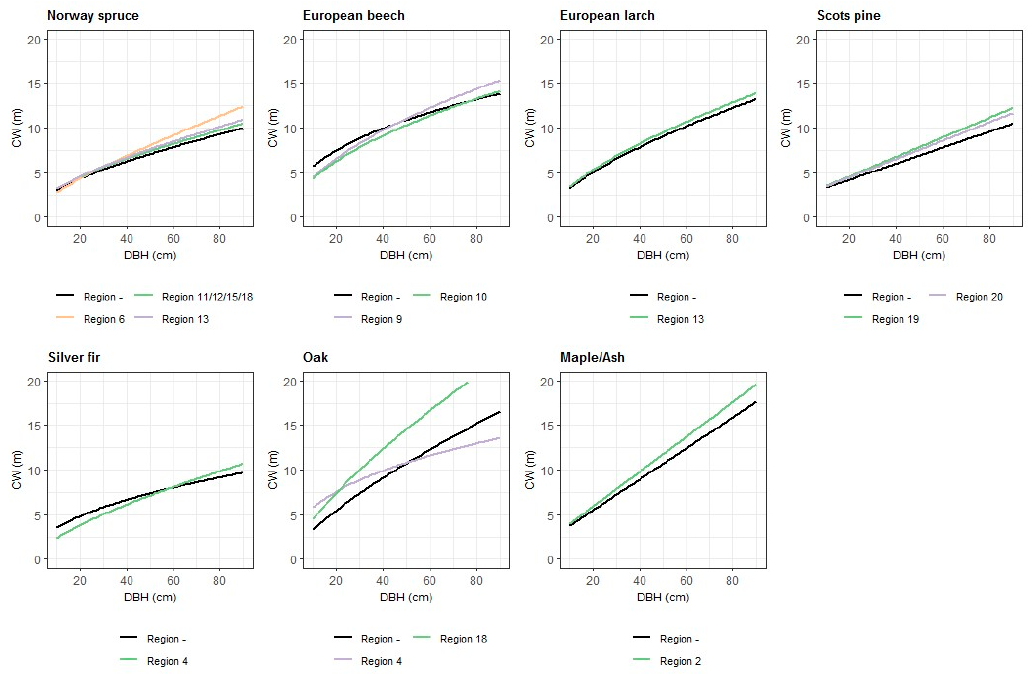
Figure 1. Effects of DBH (cm) and growth region on the CW (m) for different tree species in pure stands. The figures were produced using the parameter estimates for the fixed effects in Tables 3 and 4. For variables, which are not shown in this figure, the mean values of the observed data were used. The effect of the species composition (Figure 2) of the stand on CW was described by the Norway spruce’s own proportion of the basal area (PS_1), the interaction between ELEV and PS_1,